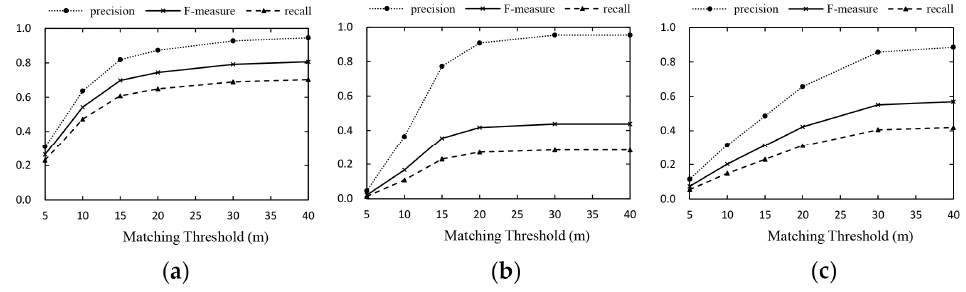
Figure 13. Accuracy analysis of intersections from the Chicago dataset. ( a ) Proposed method; ( b ) Davies’s method; and ( c ) Ahmed’s method.